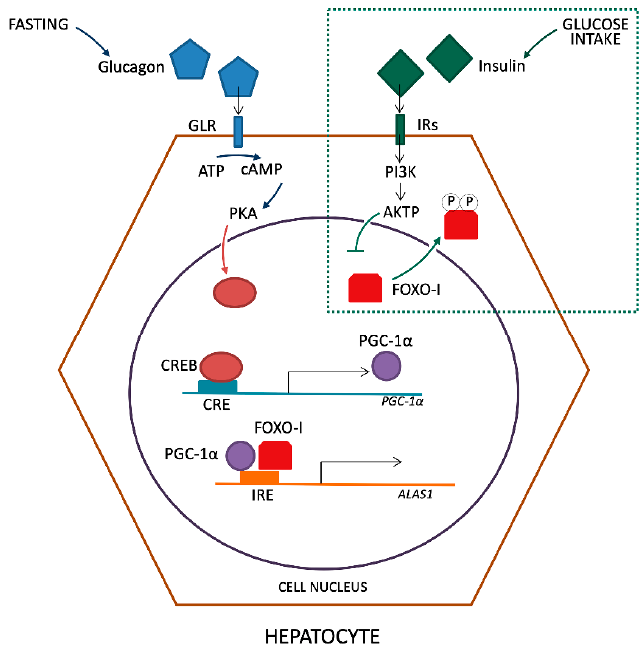
Figure 2. Regulation of ALAS ‐ 1 transcription by glucagon and insulin.